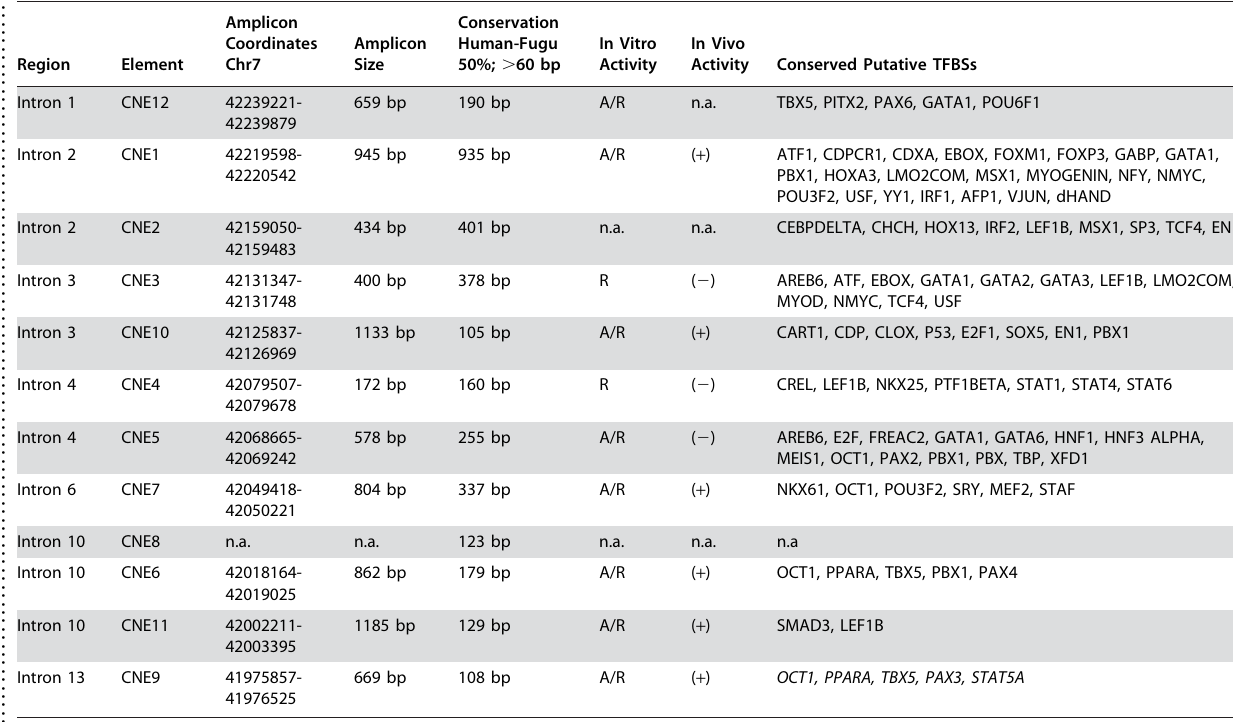
Table 1. Tetrapod-Teleost Conserved Non-Coding elements (CNEs) from Introns of Human GLI3 Selected for Functional Analysis .. ... .... ... ... .... ... ... .... ... ... .... ... ... .... ... ... .... ... ... .... ... ... .... ... ... .... ... ... .... ... ... .... ... ... .... ... ... .... ... ... .... ... ... .